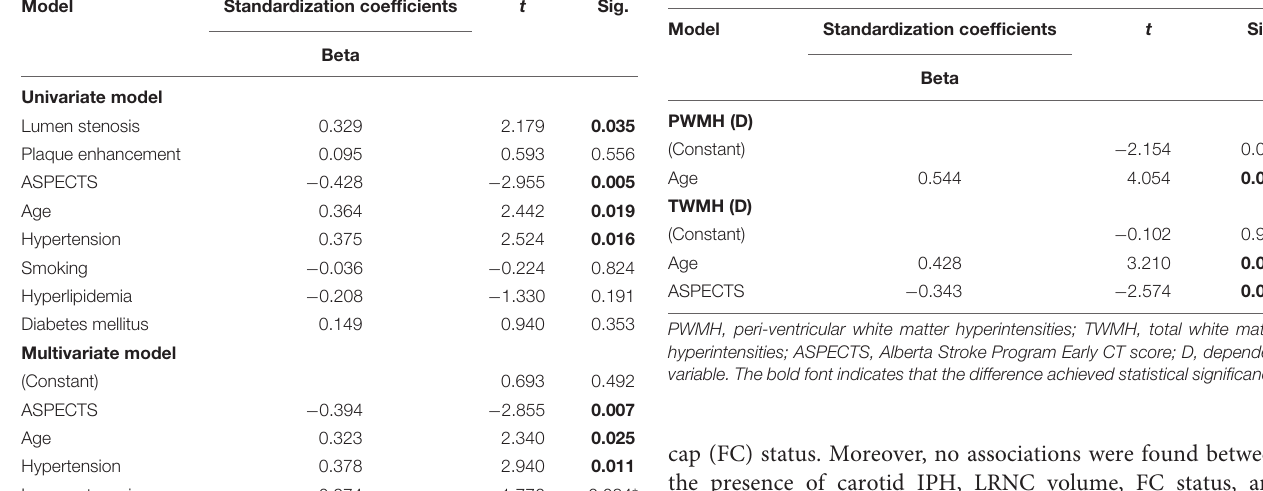
TABLE 5 | Multivariate linear regression analysis of the relationship among PWMH volume, TWMH volume ipsilateral to the ICAS site, and demographic, clinical, and radiological